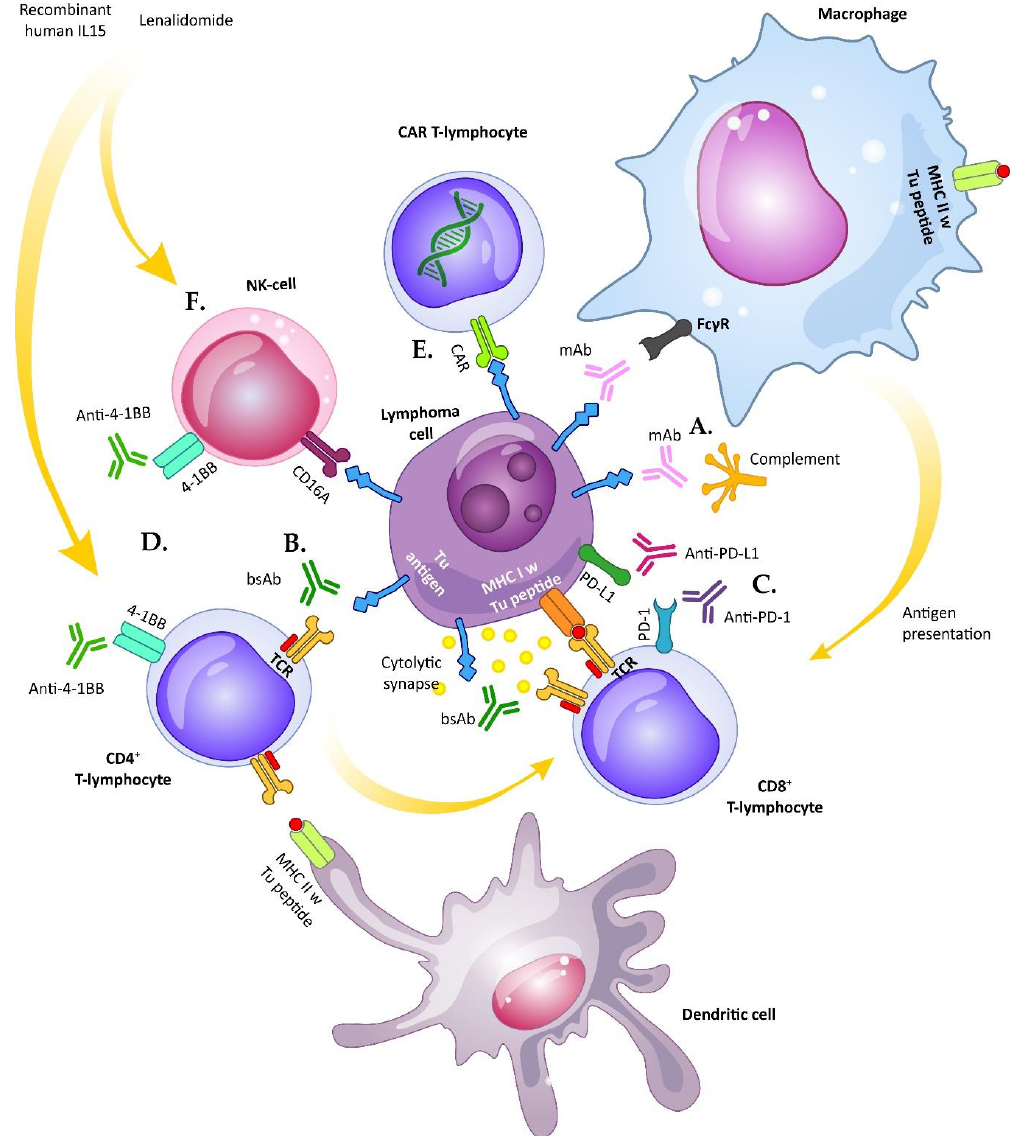
Figure 1. Overview of immunotherapy approaches in non-Hodgkin lymphomas. Legend: Simplified overview of basic principles of immunotherapy including monoclonal antibodies ( A ), bispecific antibodies ( B ), checkpoint inhibitors (PD-1, PD-L1) ( C ), activators of co-stimulatory molecules (4-1BB) ( D ), CARs ( E ), and immunomodulation ( F ). Abbreviations: bsAb = bispecific antibody; CAR = chimeric antigen receptor; FcγR = receptor for constant fragment (Fc) of immunoglobulin gamma; mAb = monoclonal antibody; MHC = major histocompatibility complex; NK = natural killer; PD-1 = programmed cell death 1; PD-L1 = PD-1 ligand 1; TCR = T-cell receptor; Tu =